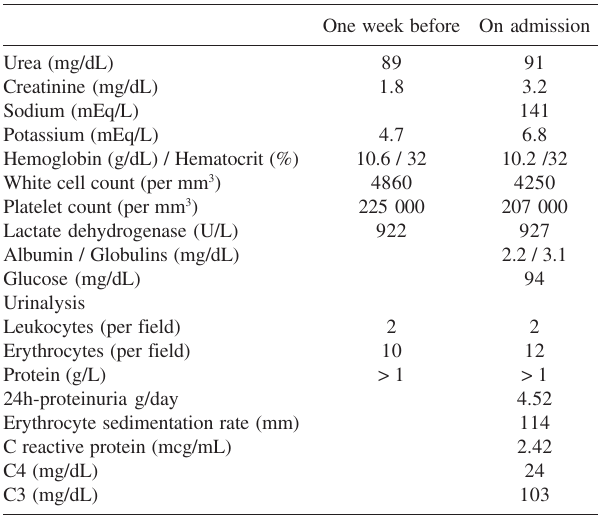
Table 1 - Results of laboratory